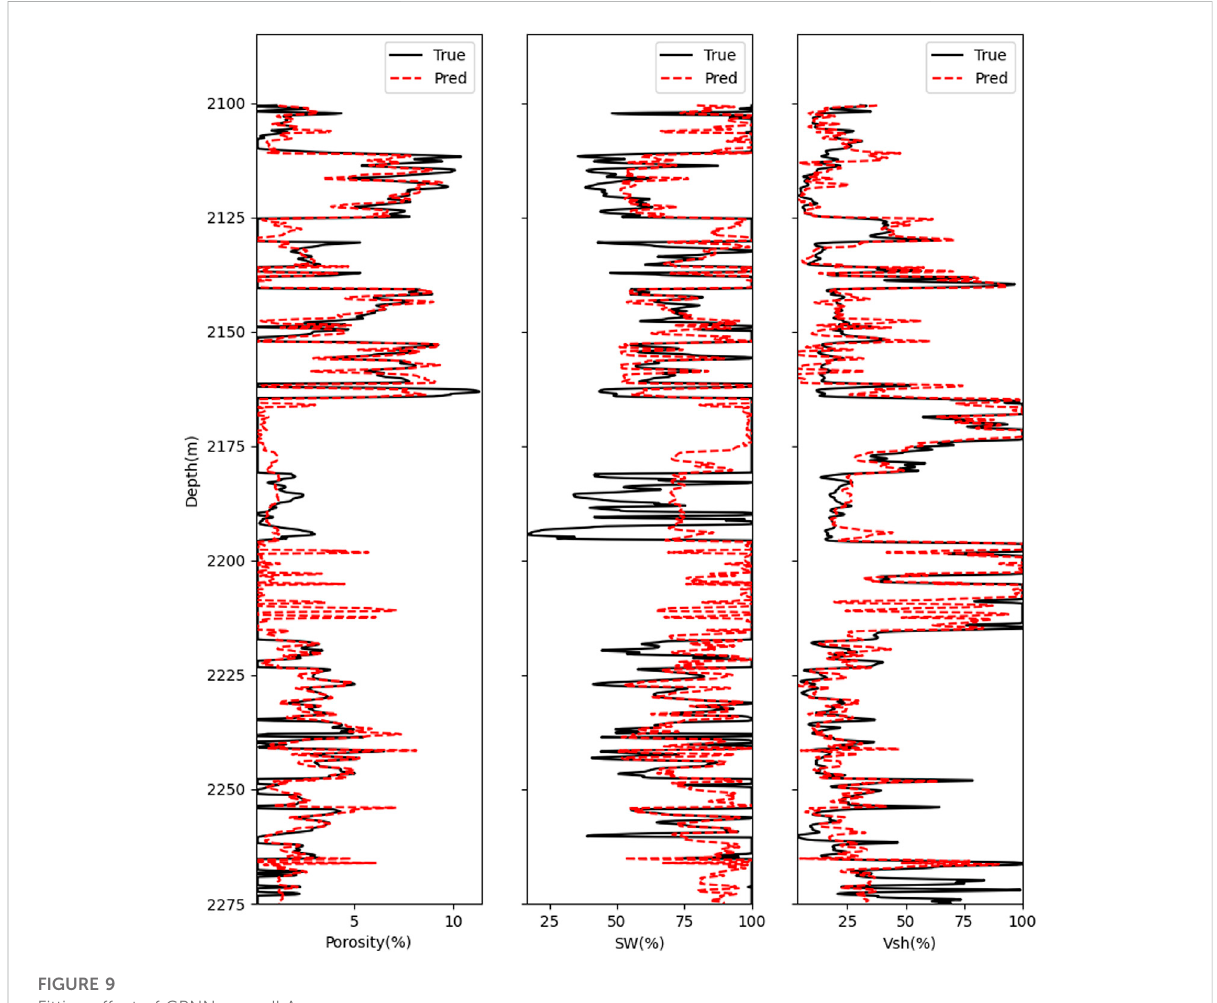
FIGURE 9 Fitting effect of GRNN on well